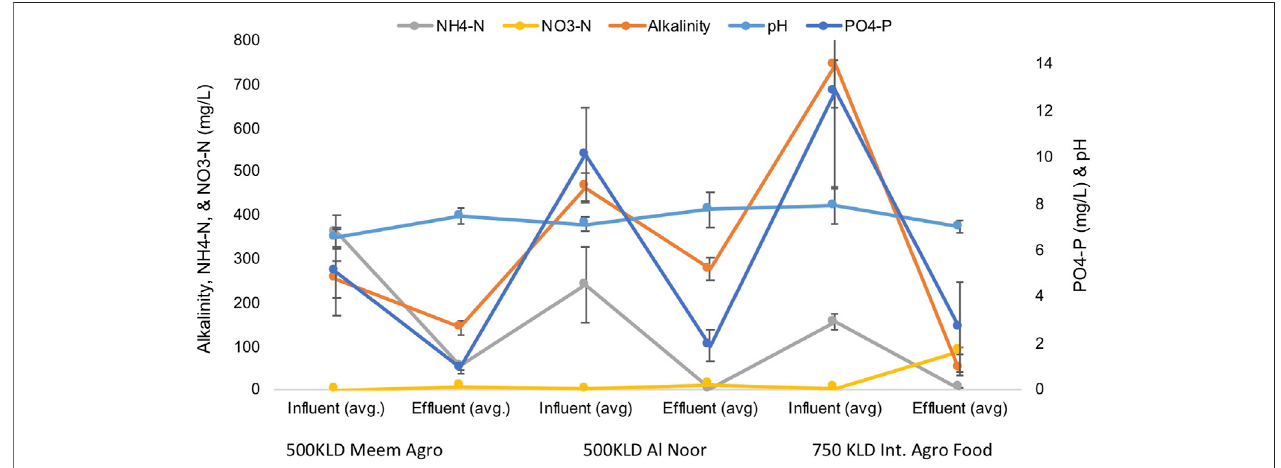
FIGURE 7 | pH, alkalinity, and NH 4 -N and NO 3 -N pro fi les during the abattoir wastewater treatment process.